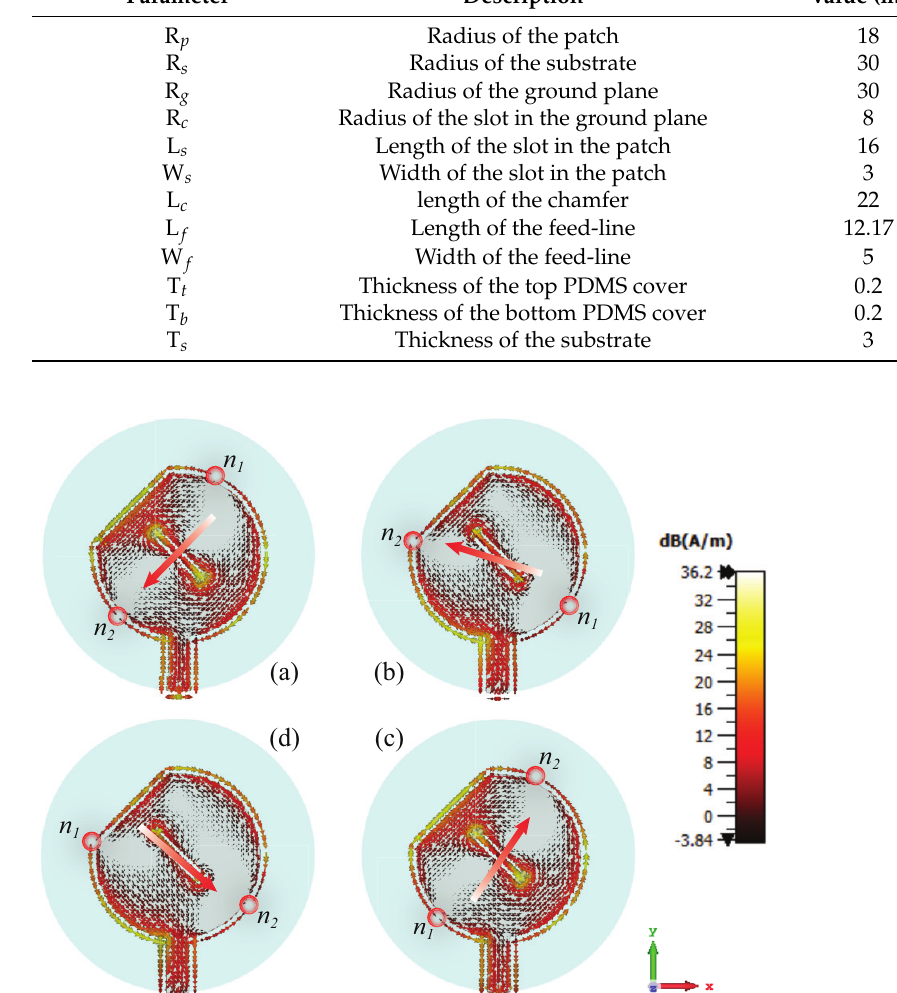
Figure 2. Surface current distribution of the antenna at 2.4 GHz at the time phases ( a ) 0 ◦ , ( b ) 90 ◦ , ( c ) 180 ◦ and ( d ) 270 ◦